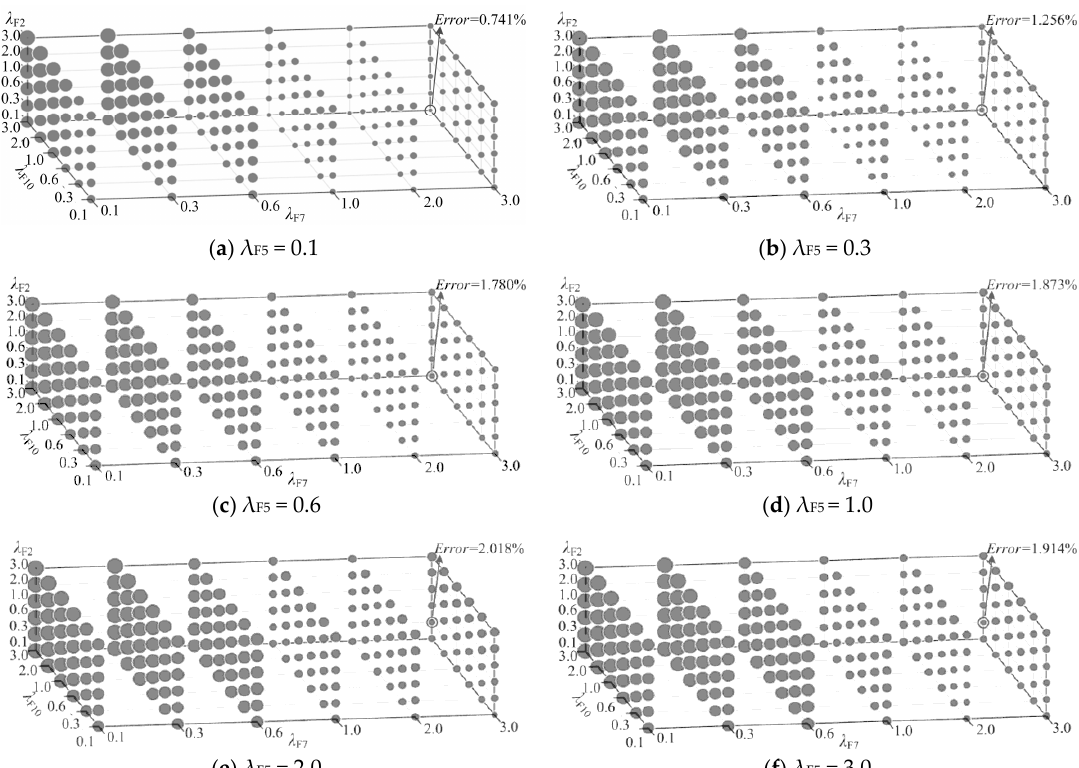
Figure 10. The error of PNN classification with the width factors combination [ λ F2 λ F5 λ F7 λ F10 ] varying in the range of 0.1–3.0 (the smaller the radius of sphere, the smaller its corresponding classification error).